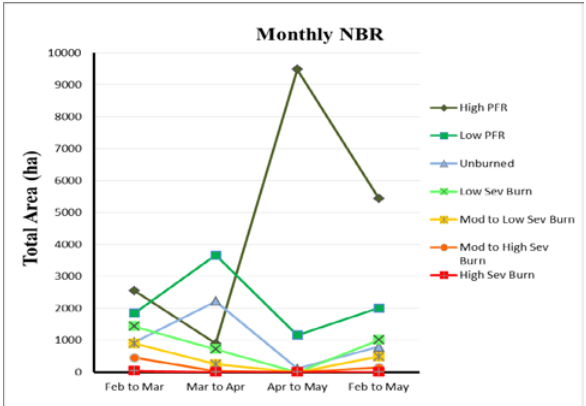
Figure 3. Total burned area per severity class of monthly dNBR and maximum dNBR (Feb to May) using Landsat 8